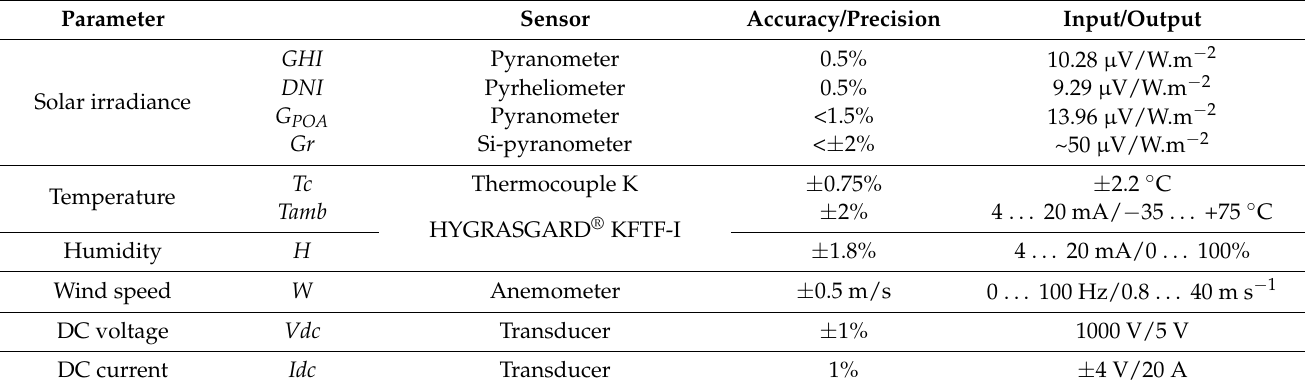
Figure 2. Testbed diagram for the bifacial modules; DNI , the direct normal irradiance; GHI the global horizontal irradiance; G POA the plan of array irradiance; Gr NA and Gr HA the rear irradiance for the normal and high albedos, respectively; TC the operating temperature on the PV arrays; Tamb ambient temperature; H humidity; W wind speed; Idc MPPT current; and Vdc MPPT voltage. Table 2. Sensors and the measured parameters.